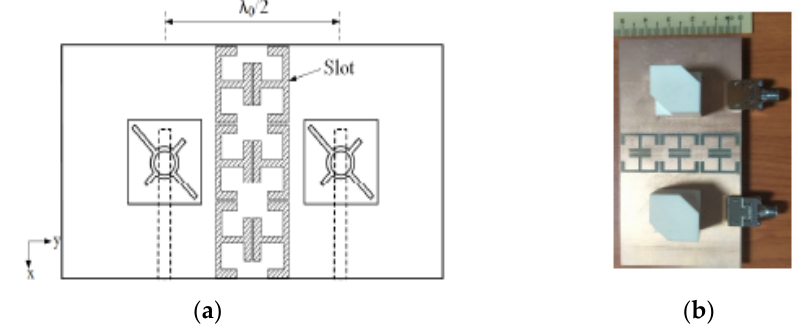
Figure 14. Proposed MIMO DRA: ( a ) front view; ( b ) fabricated antenna [65]. In [66], an integrated four-element DR based on a MIMO polarization diversity antenna is demonstrated for vehicular communication. The proposed antenna comprises two conformal open-loop fed DRA elements (Ant. 1 and Ant. 2), and two microstrip-slot fed DRA elements (Ant. 3 and Ant. 4). As shown in Figure 15, Ant. 1 and Ant. 2 are located at the top of the substrate and placed diagonally. RHCP and LHCP waves are excited in Ant. 1 and Ant. 2, respectively, to establish polarization diversity. Similarly, Ant. 3